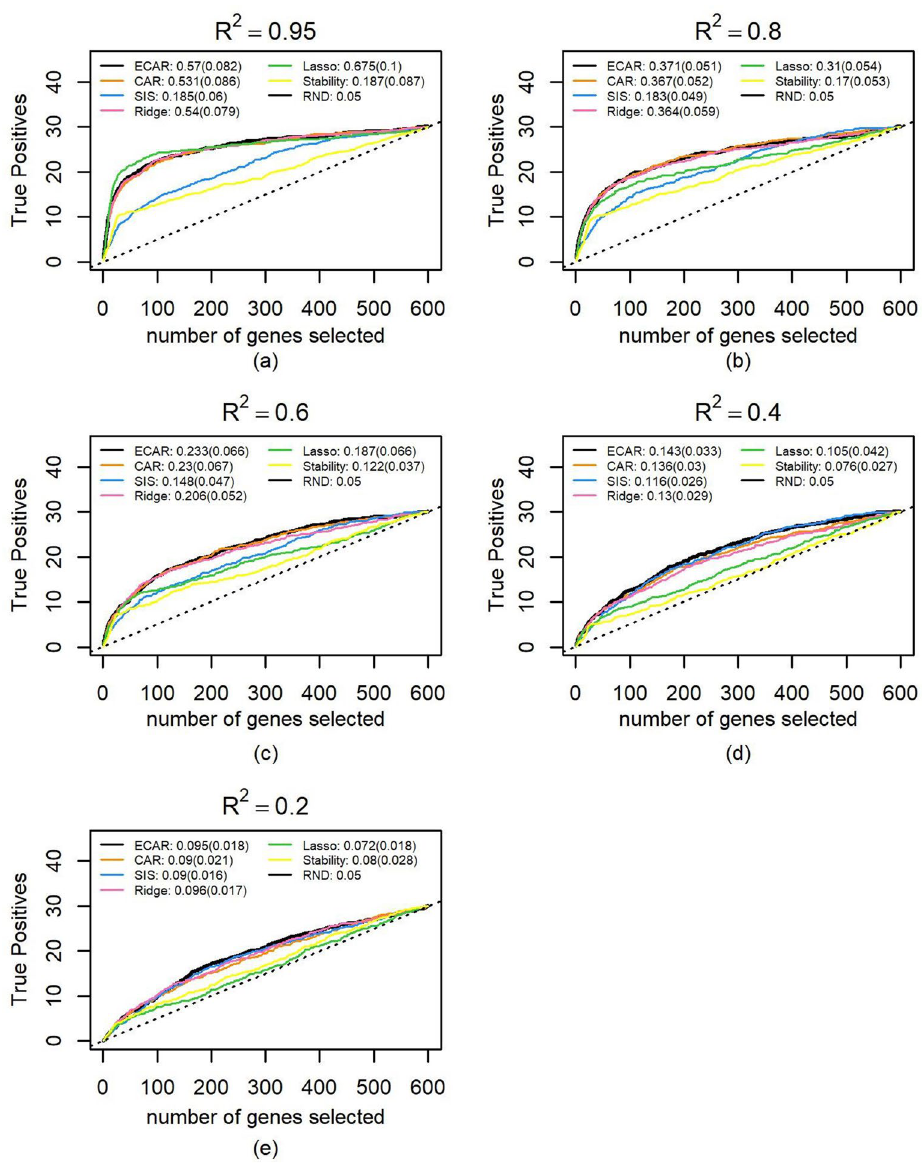
Figure 5. Comparison of feature selection performance on 500 simulated datasets. This figure is the same as Fig. 3 except that the influential features are selected from the whole set of features